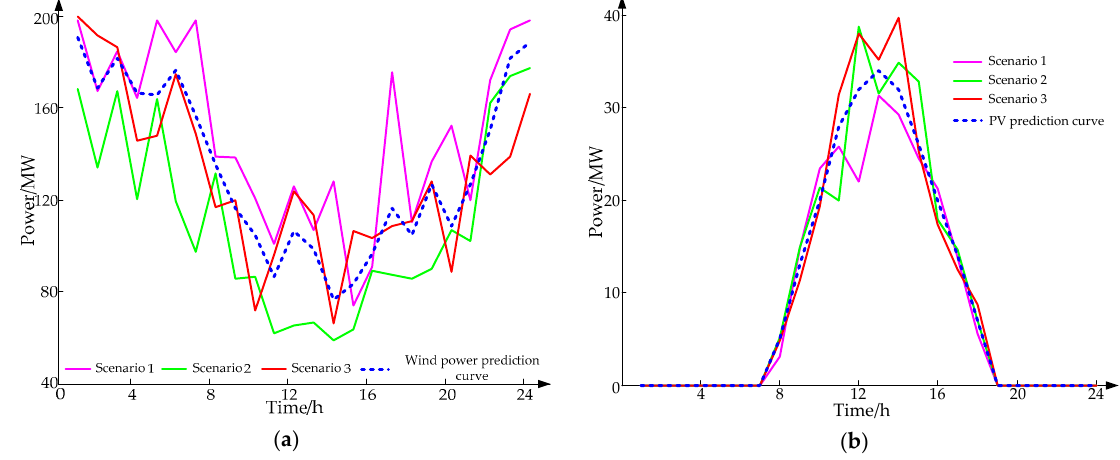
Figure 7. The WP scenarios ( a ) and the PV scenarios ( b ) based on LHS method.